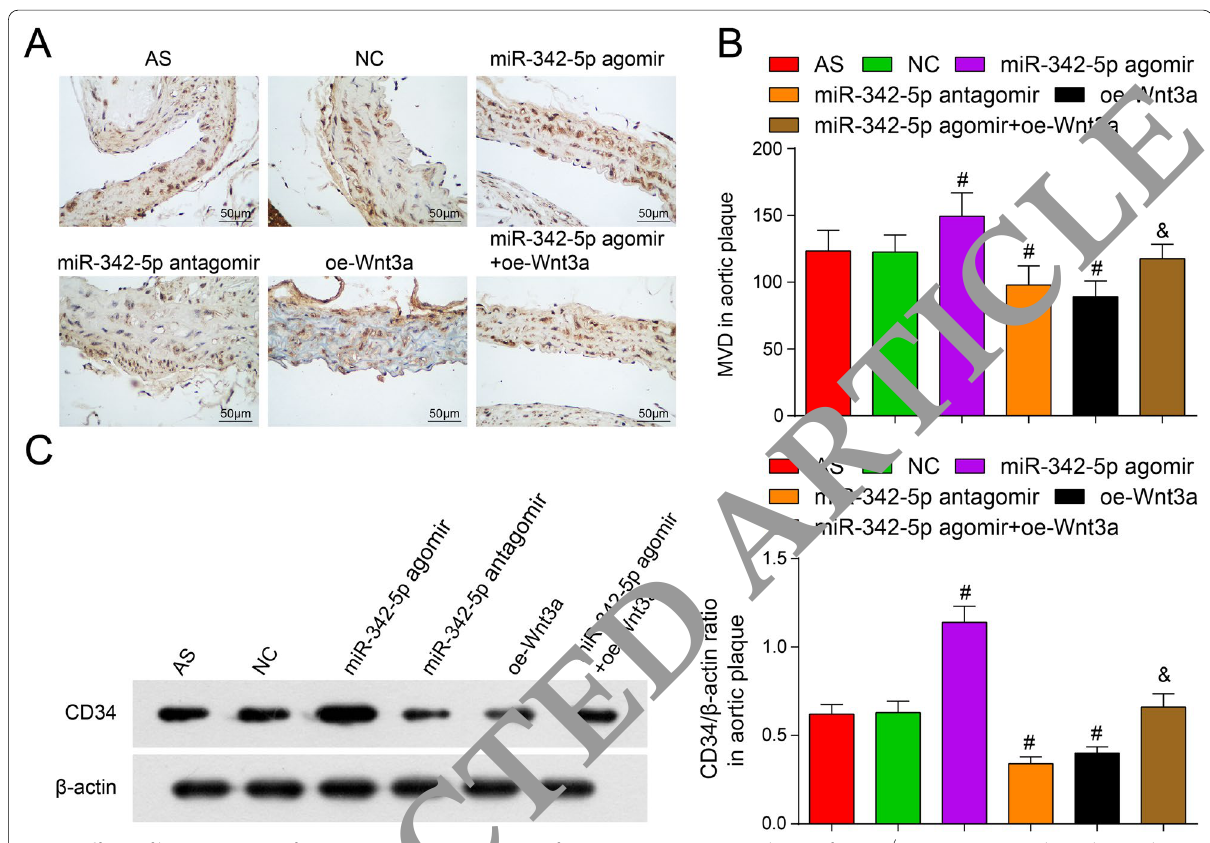
Fig. 6 Effects of low expression of miR-342-5p or overexpression of Wnt3a on MVD in aortic plaque of ApoE − / − mice. A Immunohistochemical staining of CD34 in each group of ApoE − / − mice (scale bar: 50 μm). B Comparison of MVD in aortic plaque in ApoE − / − mice. C Comparison of CD34 protein expression in ApoE − / − mice. n 12. # P < 0.05 vs. the NC group. & P < 0.05 vs. the miR-342-5p agomir group. Measurement data were = indicated as mean standard deviation. Comparisons among multiple groups were assessed by one-way ANOVA followed by Tukey’s multiple ± comparisons test. AS, atherosclerosis; NC, negative